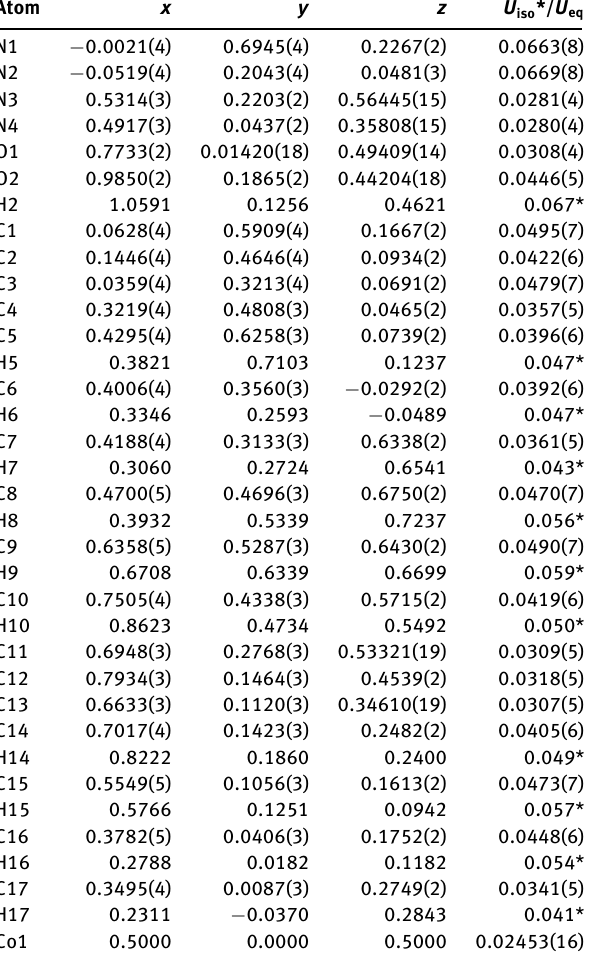
Table 2: Fractional atomic coordinates and isotropic or equivalent isotropic displacement parameters (Å 2